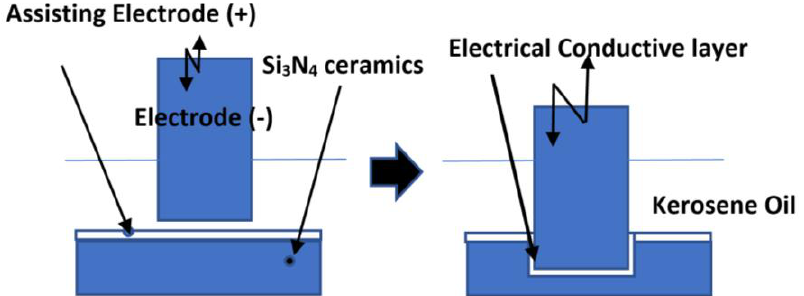
Figure 16. Basic principle of EDM of non-conducting ceramics with an Assisting electrode. Reproduced with permission from [53].